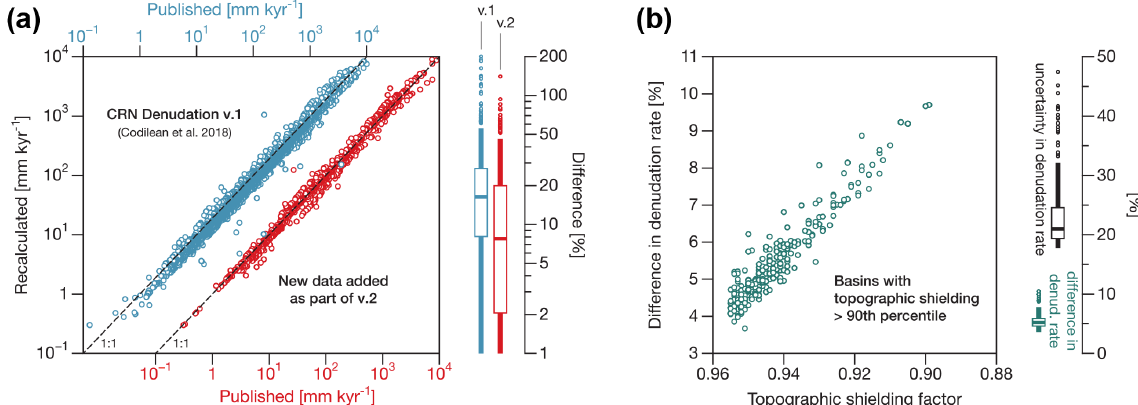
Figure 8. Technical validation of the CRN Denudation data collection. (a) Published versus recalculated 10 Be-based denudation rates. Blue circles represent 10 Be data from the first version of the OCTOPUS database (Codilean et al., 2018), and red circles represent the 10 Be data added as part of version 2. Box plots show the percent difference between published and recalculated 10 Be-based denudation rates (blue – data in v.1; red – data added as part of v.2). (b) Comparison of 10 Be-based denudation rates calculated with and without correcting for topographic shielding for basins from the OCTOPUS v.2 database with topographic shielding values above the 90th percentile. Box plots show the percent difference in denudation rates calculated with and without correcting for topographic shielding (in green), compared with the percent uncertainty in calculated denudation rates (in black). Note how the difference in the 10 Be denudation rate obtained by ignoring topographic shielding is smaller than the uncertainty in the denudation rate calculation.